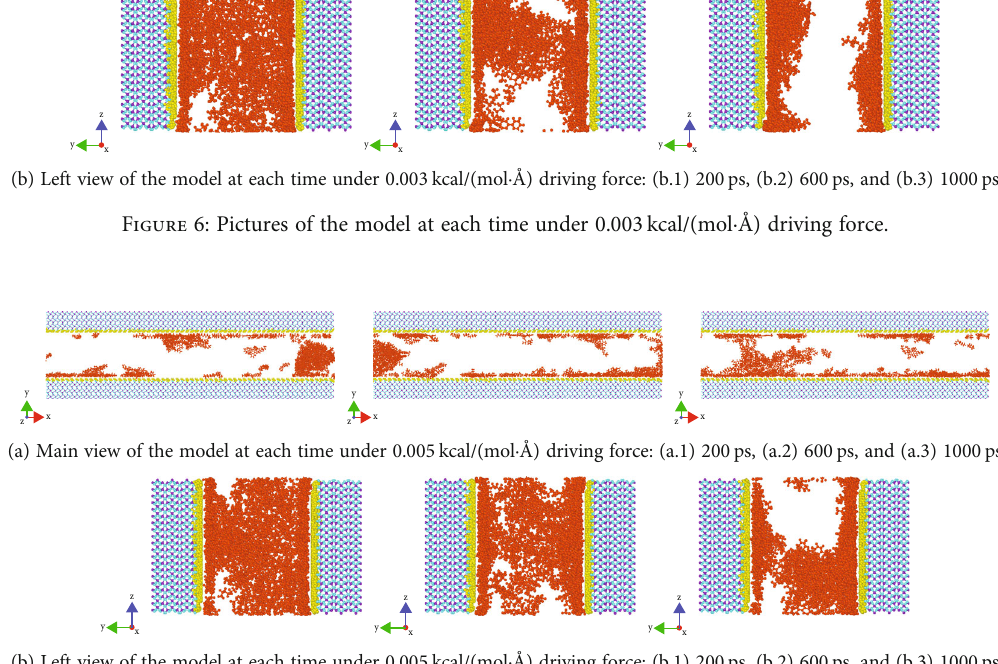
Figure 7: Pictures of the model at each time under 0.005 kcal/(mol · Å) driving